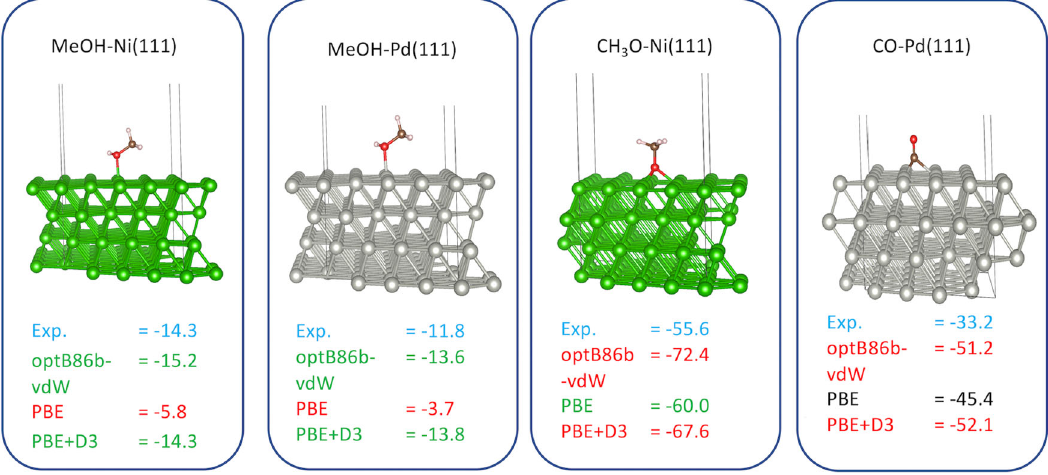
Fig. 1 | Functional dependence of computed adsorption energies. Calculated adsorption energies (kcalmol − 1 ) of methanol (MeOH), methoxy (CH 3 O) and CO on Ni(111) (green slab) and Pd(111) (gray slab) together with the experimental values.